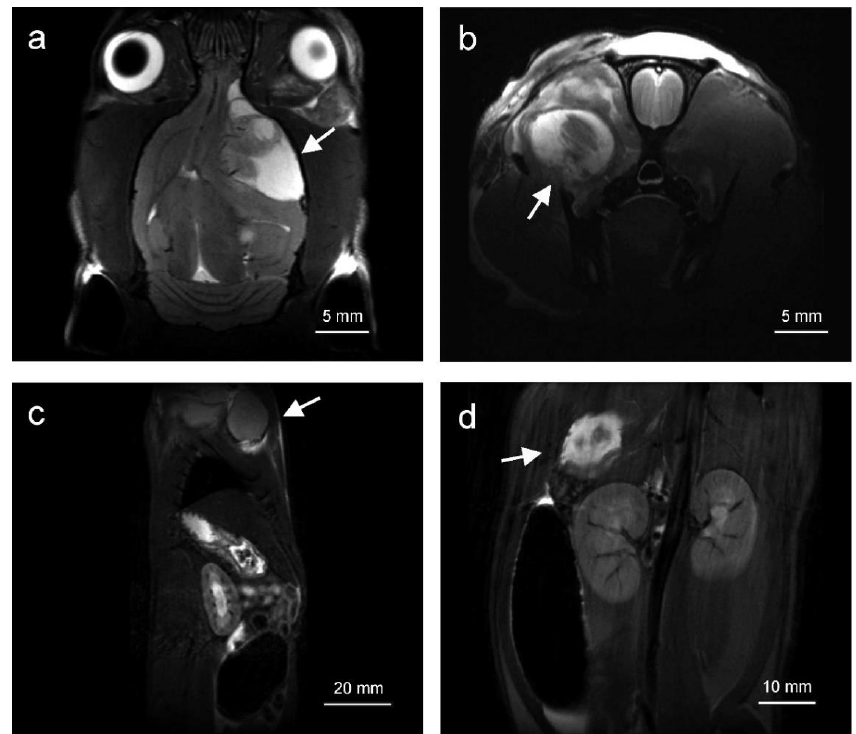
Figure 2. MR images depicting typical localization of tumors in Tp53 homozygous knockout rats. Tumors were observed inter alia in the brain ( a ), skull muscles ( b ) as well as in the abdomen ( c,d ). Arrows indicate the tumors.